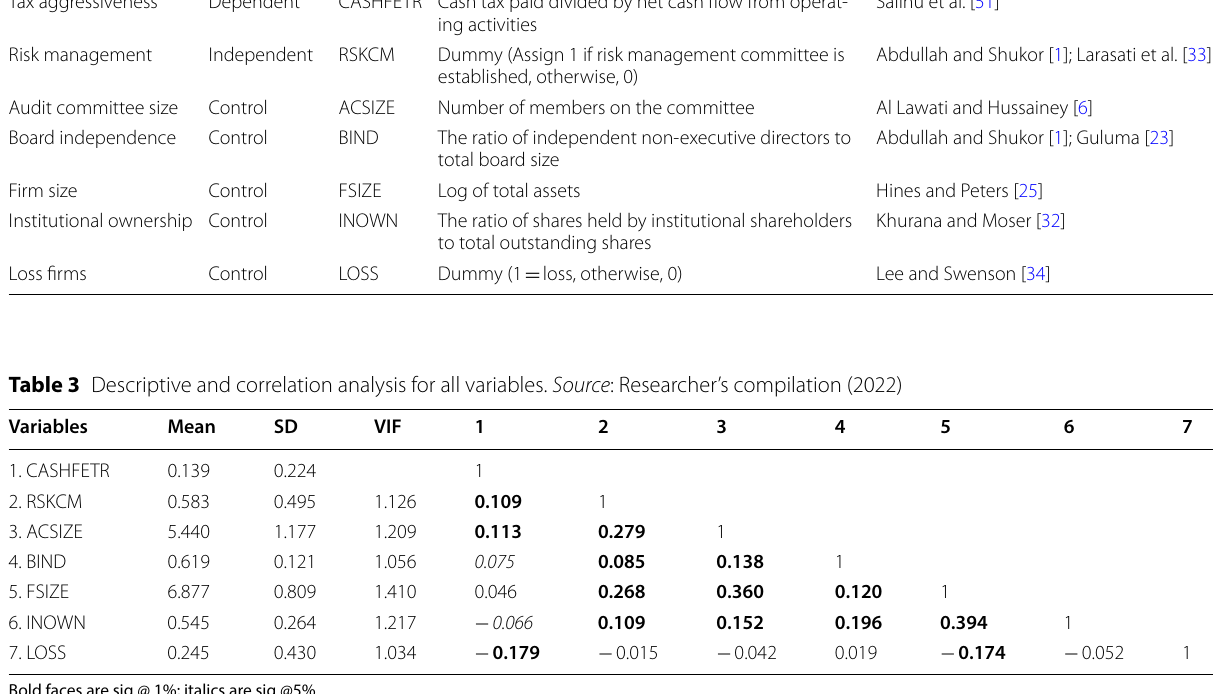
Bold faces are sig @ 1%; italics are sig @5%